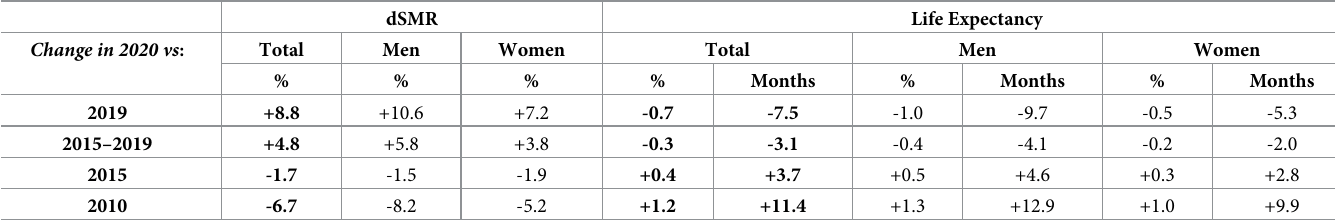
Table 1. Summary of changes in directly standardized mortality rates (dSMR) and in life expectancy comparing 2020 to previous